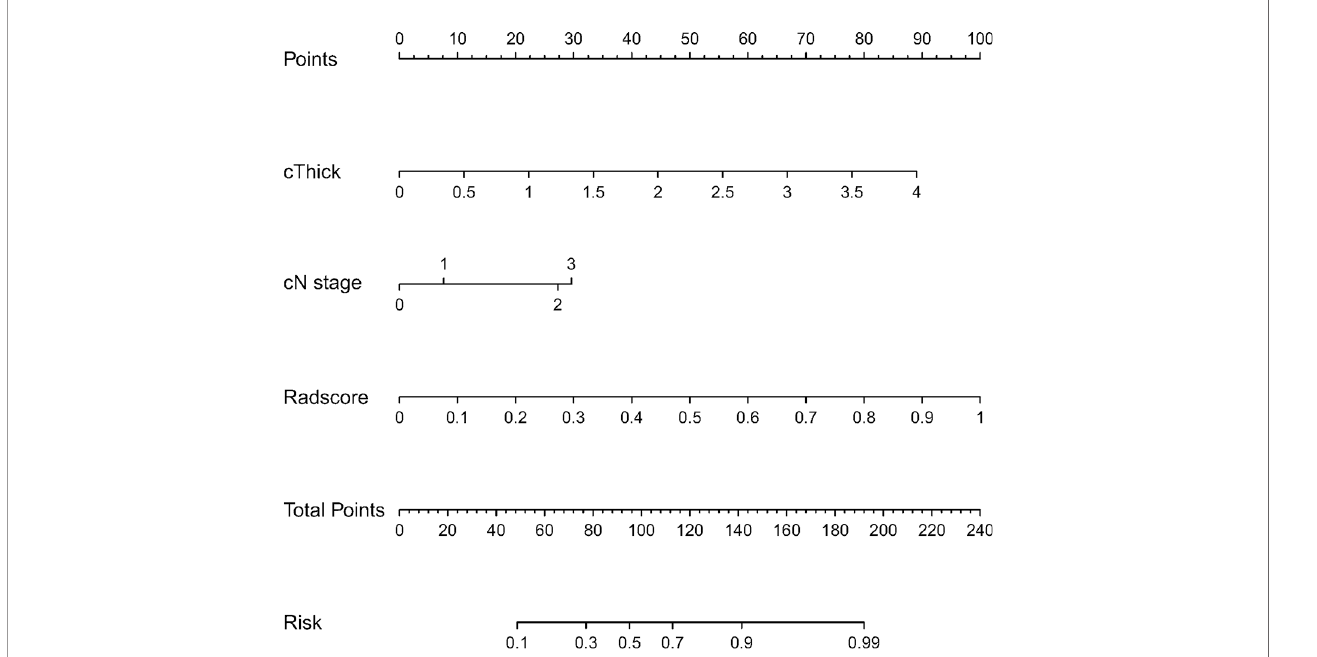
FIGURE 5 | Nomogram for predicting LVI in ESCC. The nomogram was built in the training cohort with the independent predictors from radiomics model and clinical model.